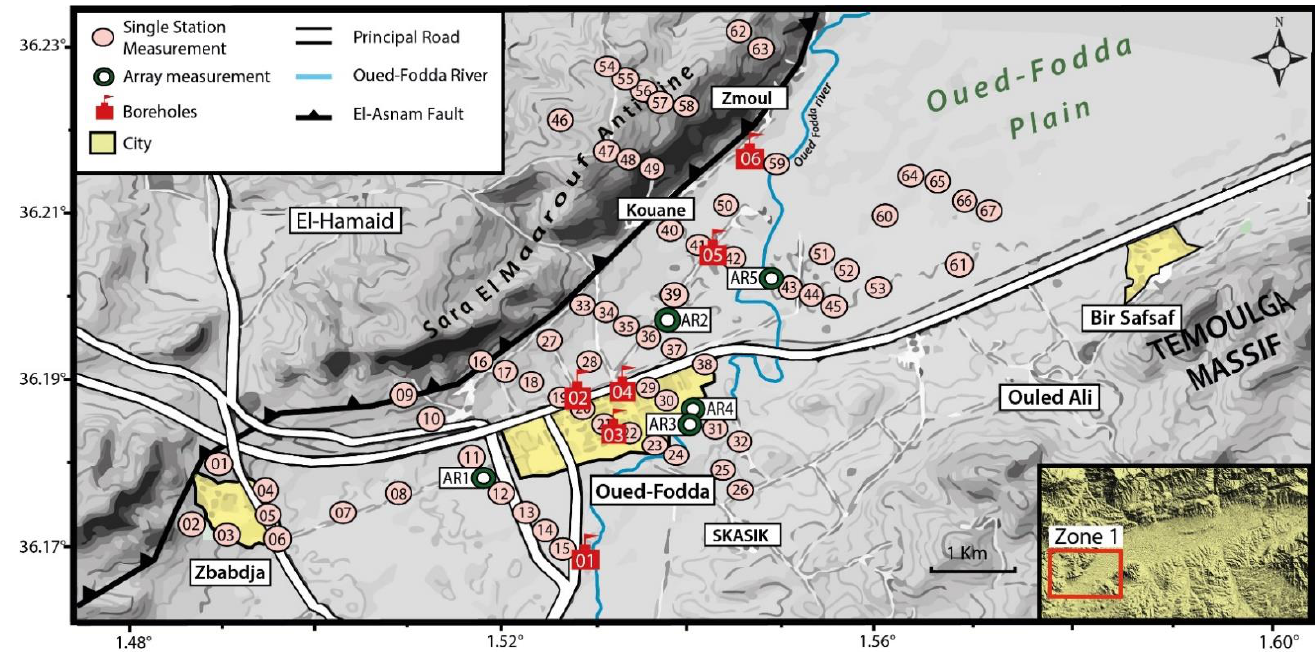
Figure 4. Compiled data in Zone 1.